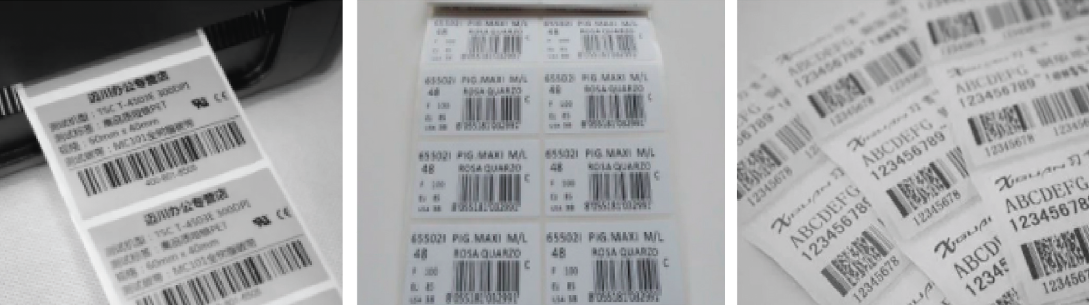
Figure 3: Various labels and barcodes of thermal printing.